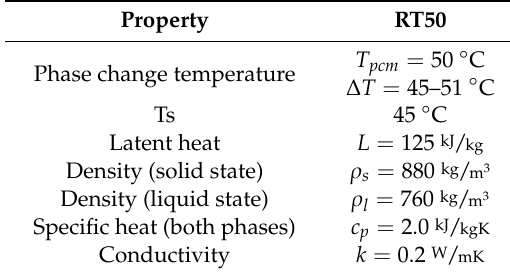
Table 2. Simulation